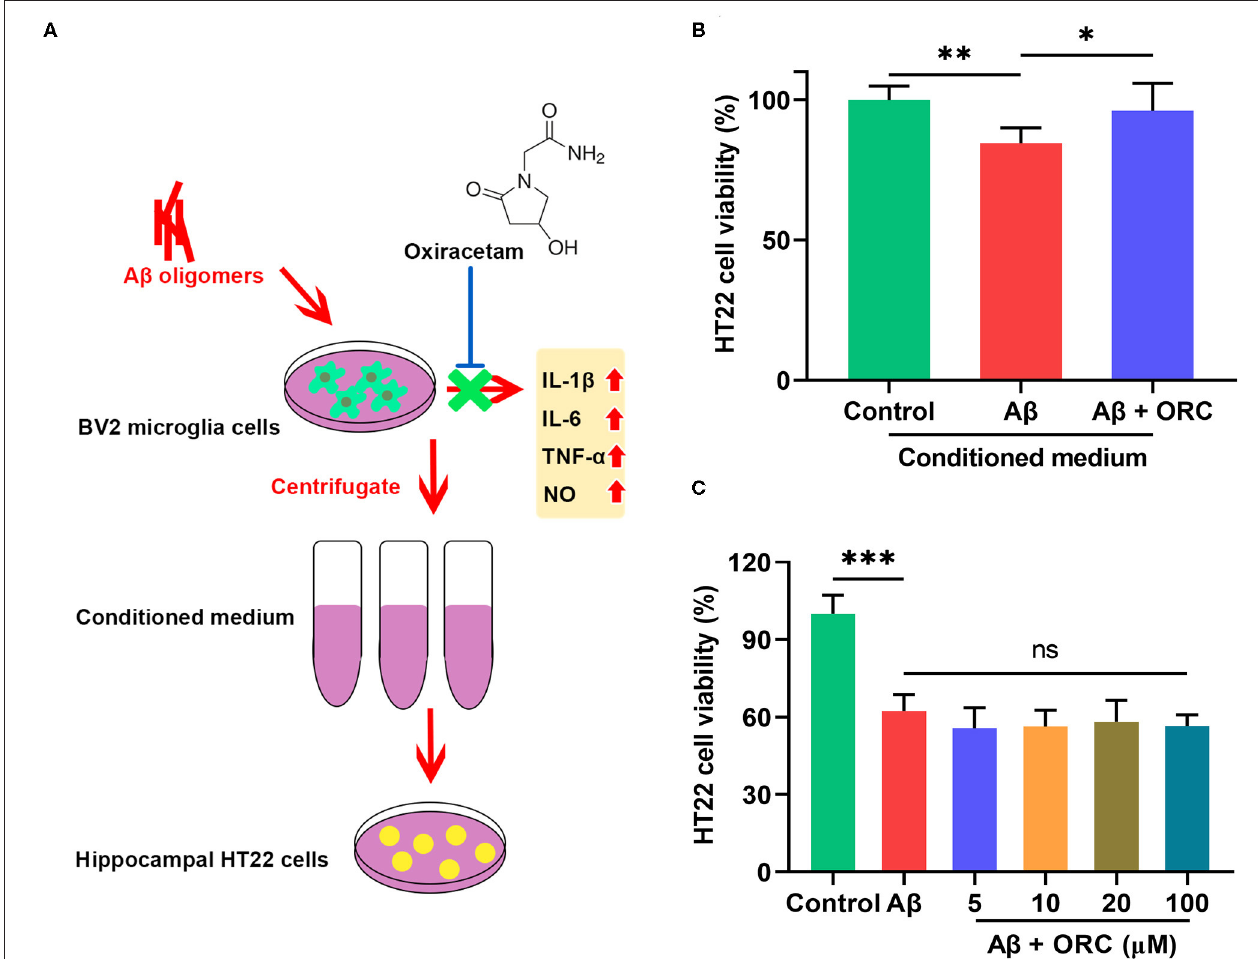
FIGURE 6 | Neuroprotective effects of oxiracetam (ORC) against indirect toxicity of microglia-conditioned medium but not direct toxicity of A β . (A) Schematic of the experimental procedure to test the indirect toxicity of A β -induced BV2 cells in the presence or absence of ORC. (B) The results of the MTT assay revealed that ORC rescued the reduction of HT22 cell viability induced by conditioned medium from A β -induced BV2 cells. (C) The A β -induced decrease in HT22 cell viability was not affected by ORC ( n = 8 for all groups). There was no significant difference between A β and A β + ORC groups. ns, not significant; * p < 0.05, ** p < 0.01, and *** p <